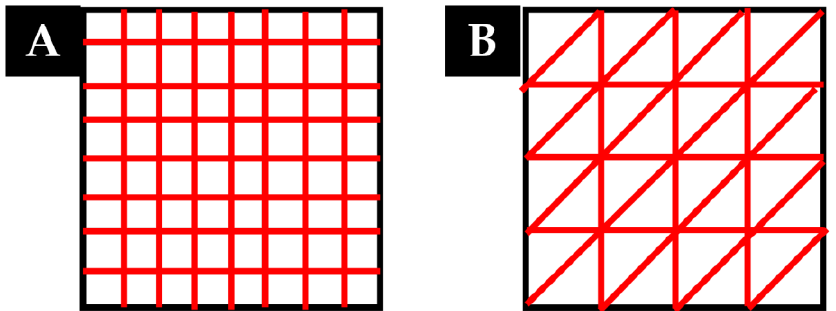
Figure 3. ( A ) Rectilinear geometric model, ( B ) Triangular geometric model. Red lines represent the extruder trajectories.